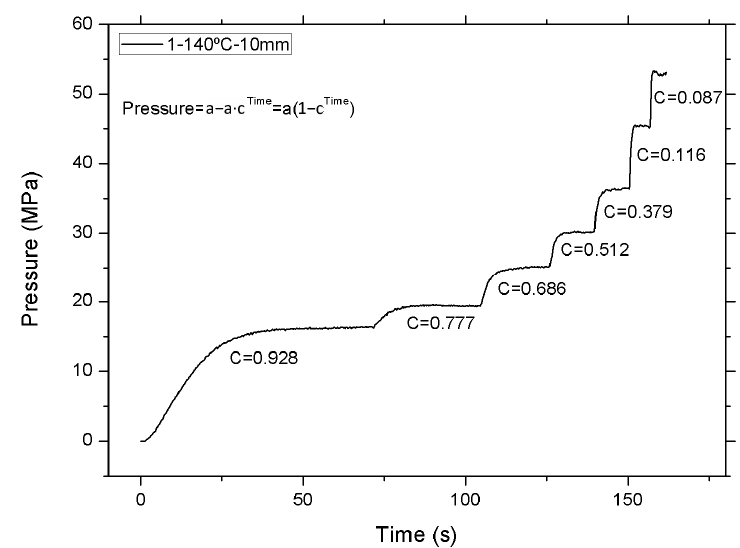
Figure 4. Evolution of the pressure versus time of the Solanyl ® at 140 °C with a nozzle length of 10 mm.